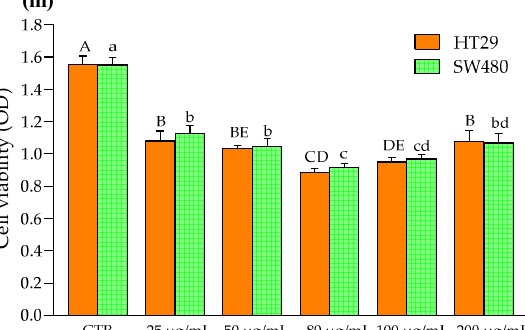
Figure 1. Effects of Aglianico GP gastrointestinal digested extract on cell proliferation of HT29 and SW480 cells treated with increasing concentrations. ( i ) Cell viability of cells after 24 h; ( ii ) Cell viability of cells after 48 h; ( iii ) Cell viability of cells after 72 h. All data are the means ± SD of three replicate measurements. Values are expressed as cell viability (optical density (OD) at 570 nm). Different capital letters (A–E) indicate a significant difference ( p < 0.05, one-way ANOVA, and Tukey’s HSD test) when comparing different GP concentrations in HT29 cell line; different lower-case letters (a–d) indicate a significant difference ( p < 0.05, one-way ANOVA, and Tukey’s HSD test) when comparing different GP concentrations in SW480 cell